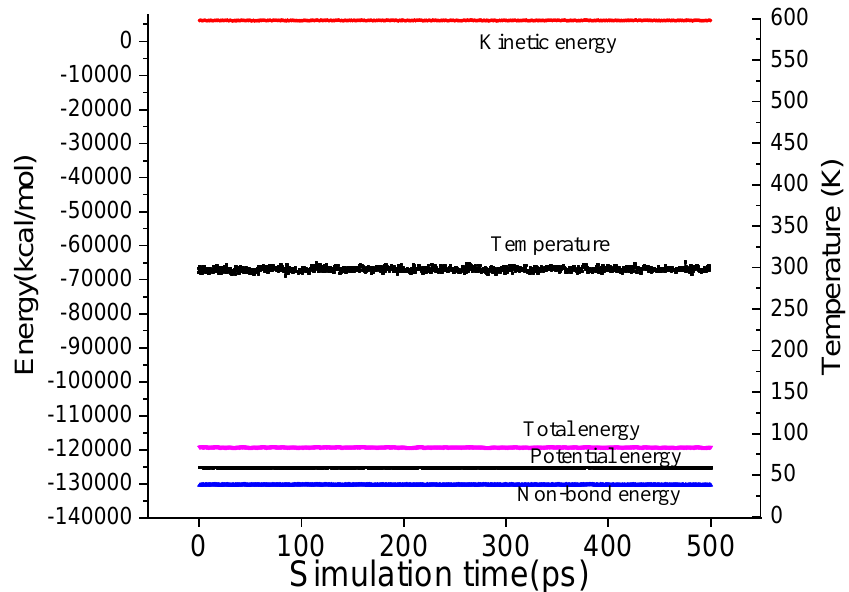
Figure 4. Energy and temperature of 37PUF-1SiO 2 -2.6% model as a function of NVT-molecular dynamics (MD) simulation time.